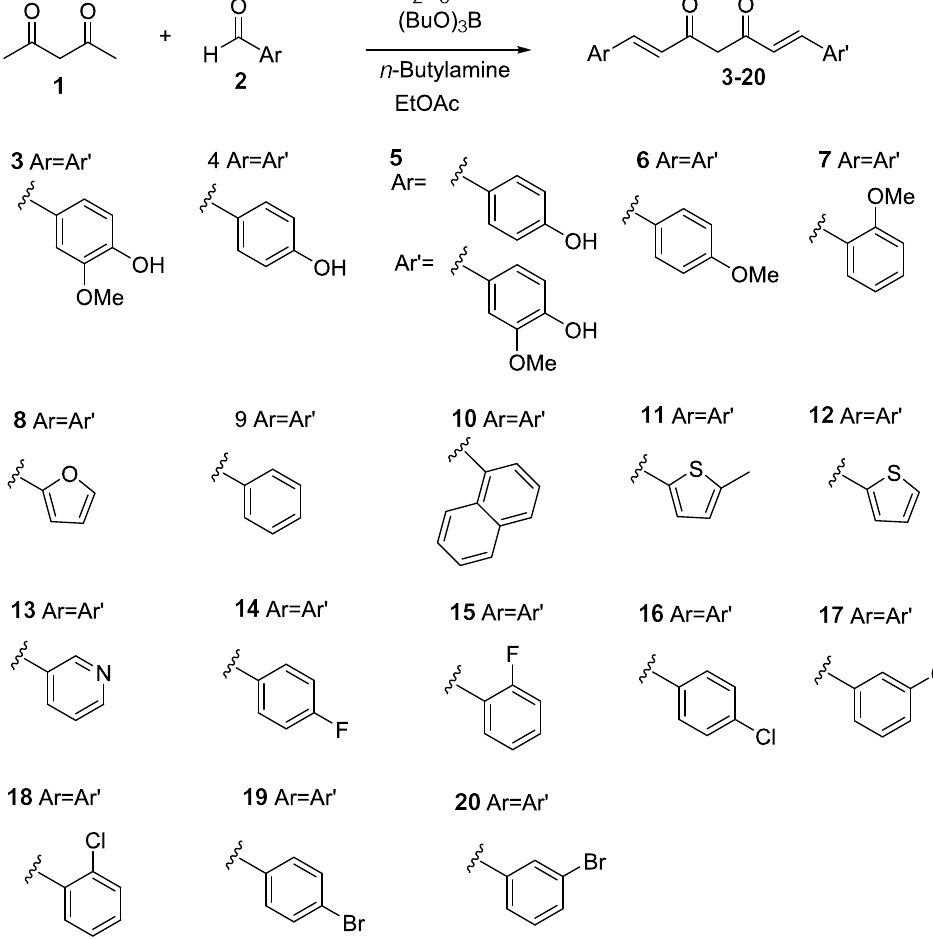
Figure 1. Chemical synthesis of curcuminoids 3 – 20